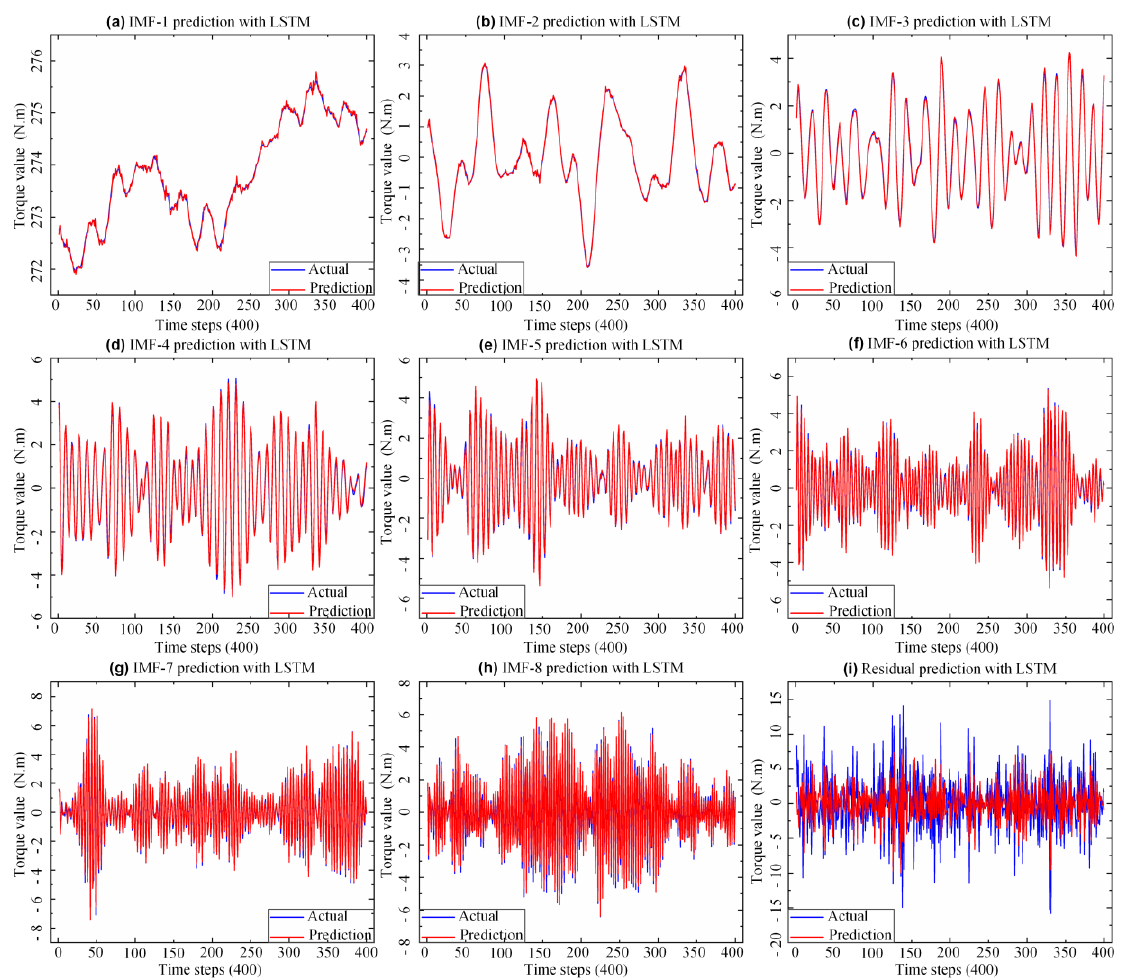
Figure 7. GWO − VMD decomposition IMFs prediction results.